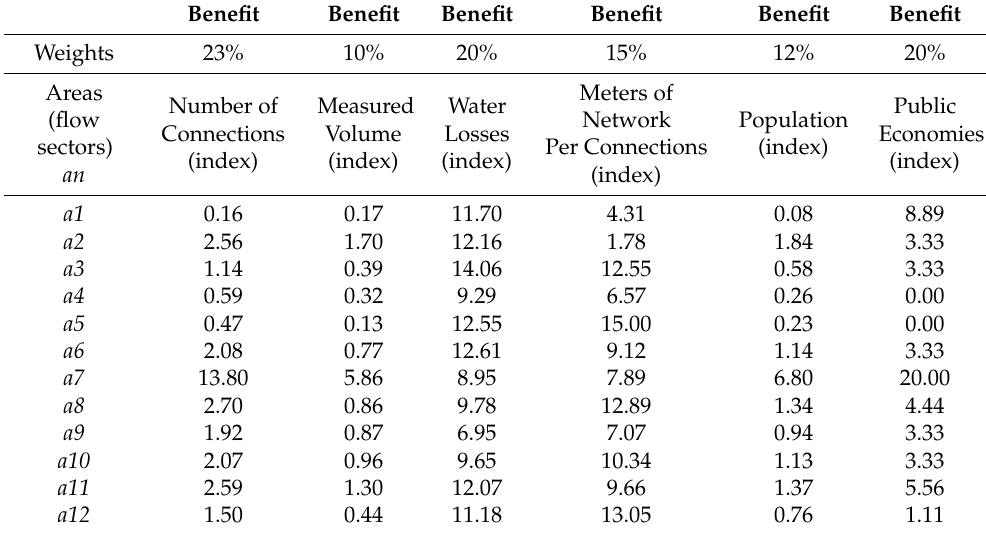
Table 5. Normalized weighted dataset—Procedure